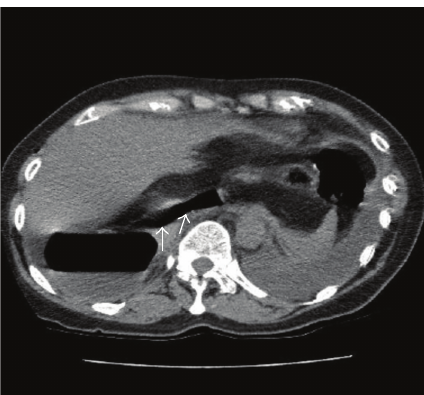
Figure 1: Computerised Tomography (CT) scan herniation of the stomach (Arrows-gastric air within the stomach) into a congenital post-diaphragmatic